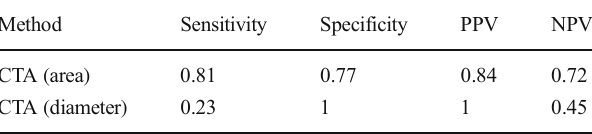
Sensitivity, specificity, positive predictive value and negative predictive value of the CTA (area)- and CTA (diameter)-based